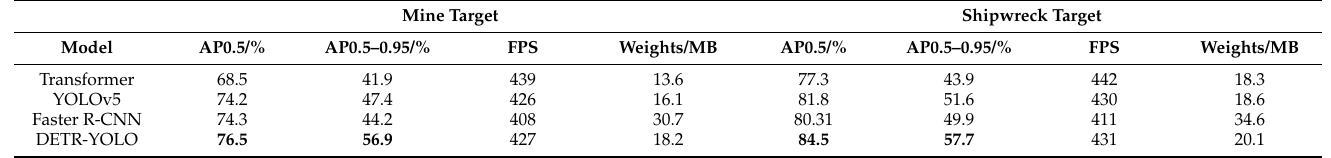
Table 8. Comparison of the detection performances of the DETR-YOLO model and conventional models.